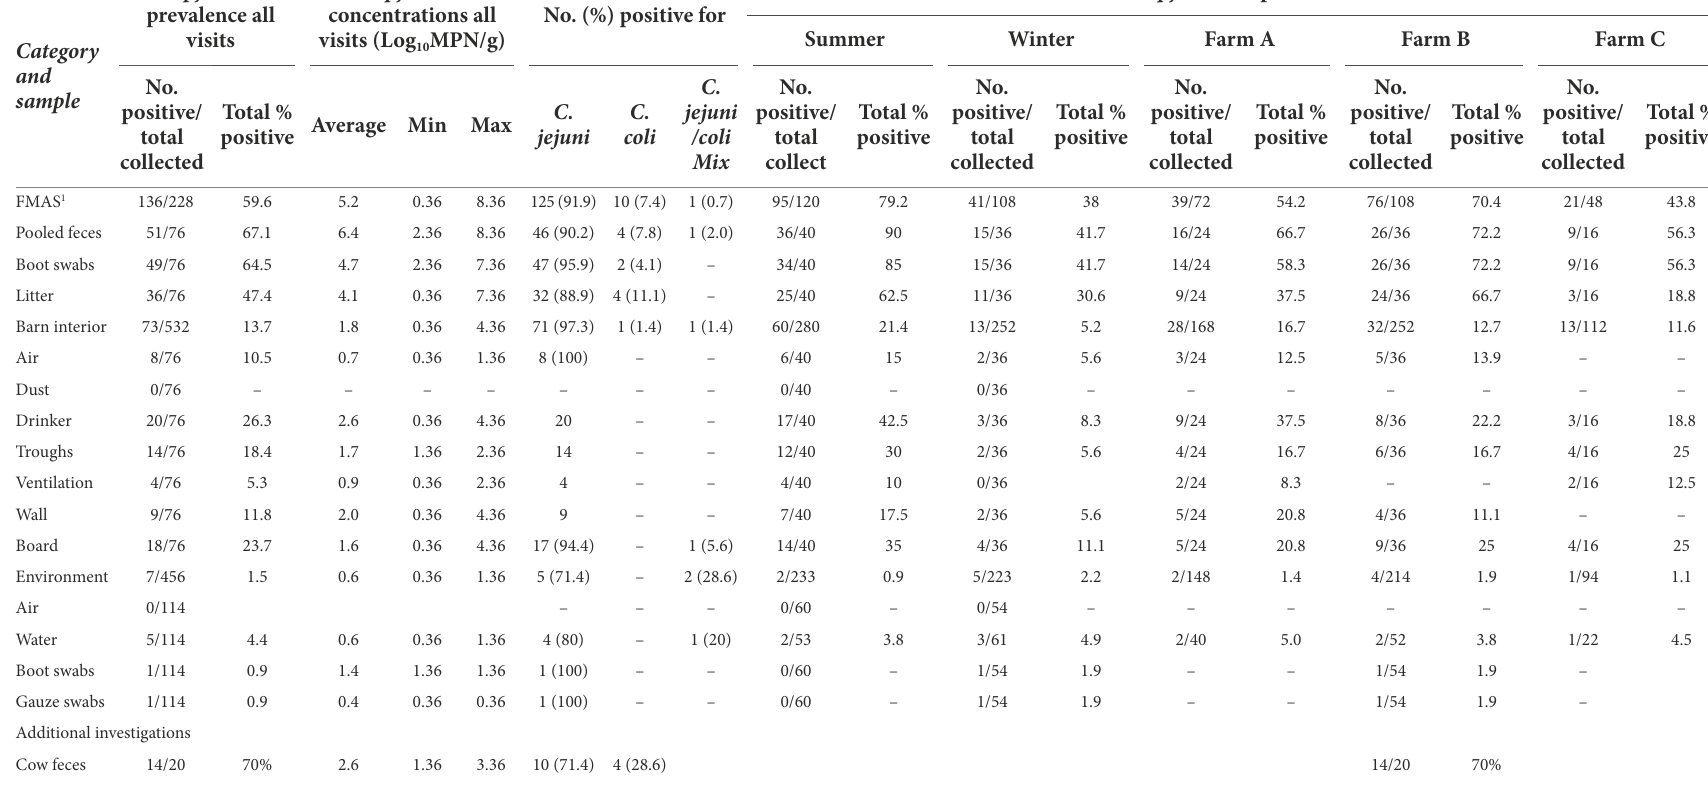
TABLE 3 Summary of total samples (concentrations, prevalence, and Campylobacter species type) collected at broiler farms in Brandenburg, Germany, 2018 to 2020.